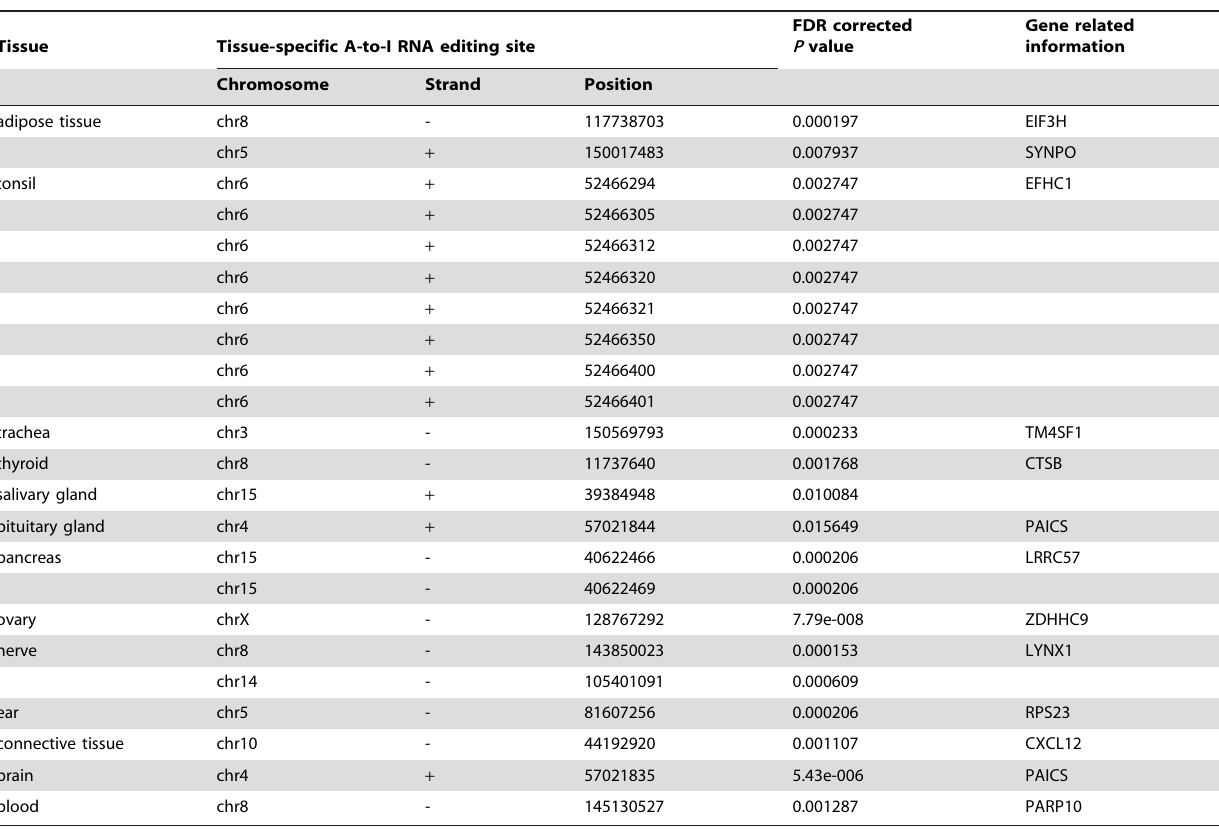
Table 1. Tissue-specific A-to-I RNA editing sites by computational detection.